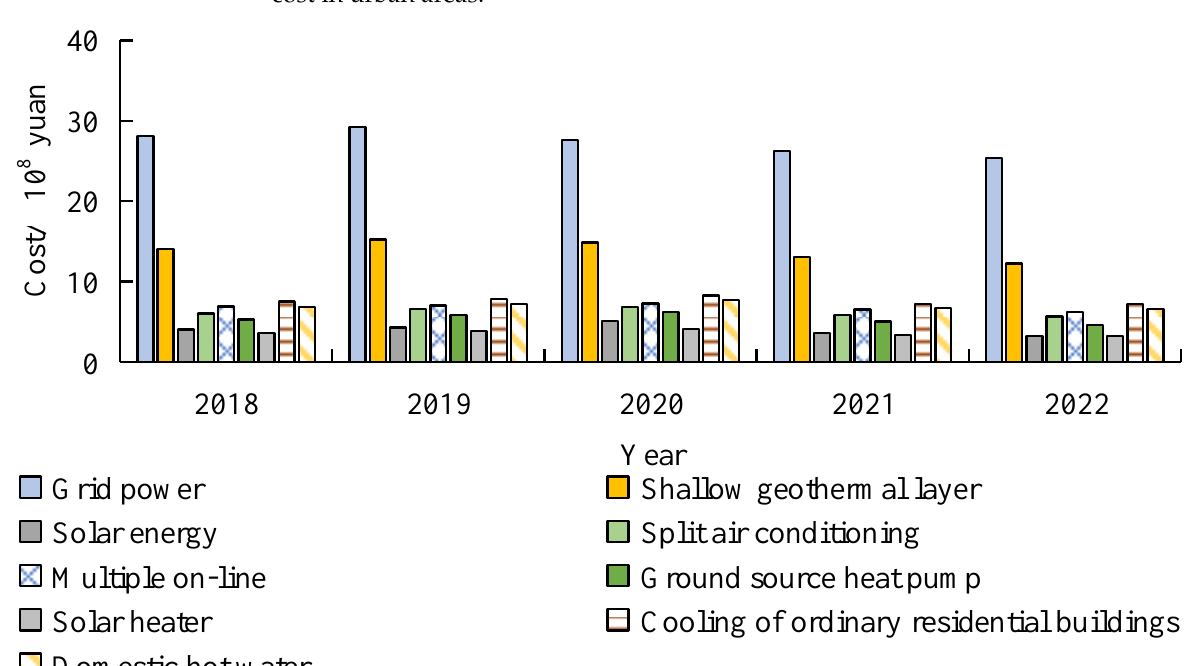
Figure 9. The cost of each part of the summer regional building energy planning model. Table 2. Results of the original energy planning model and the existing energy planning model.